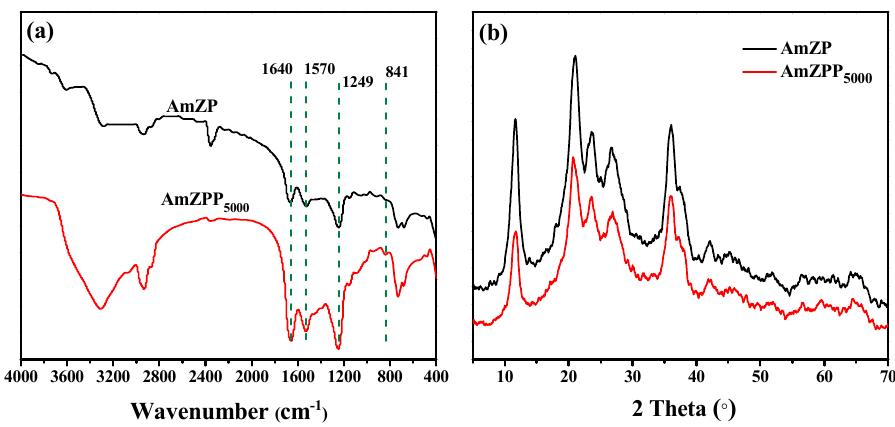
Figure 4 . FT-IR ( a ) and XRD ( b ) spectra of AmZP and AmZPP 5000 .